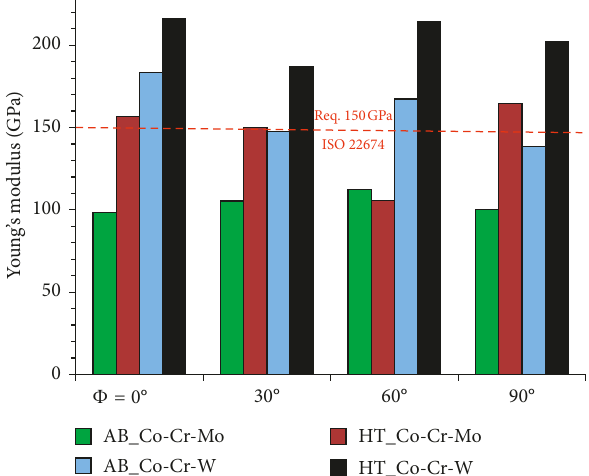
Figure 7: Mean value of E for Co-Cr-Mo and Co-Cr-W alloys.